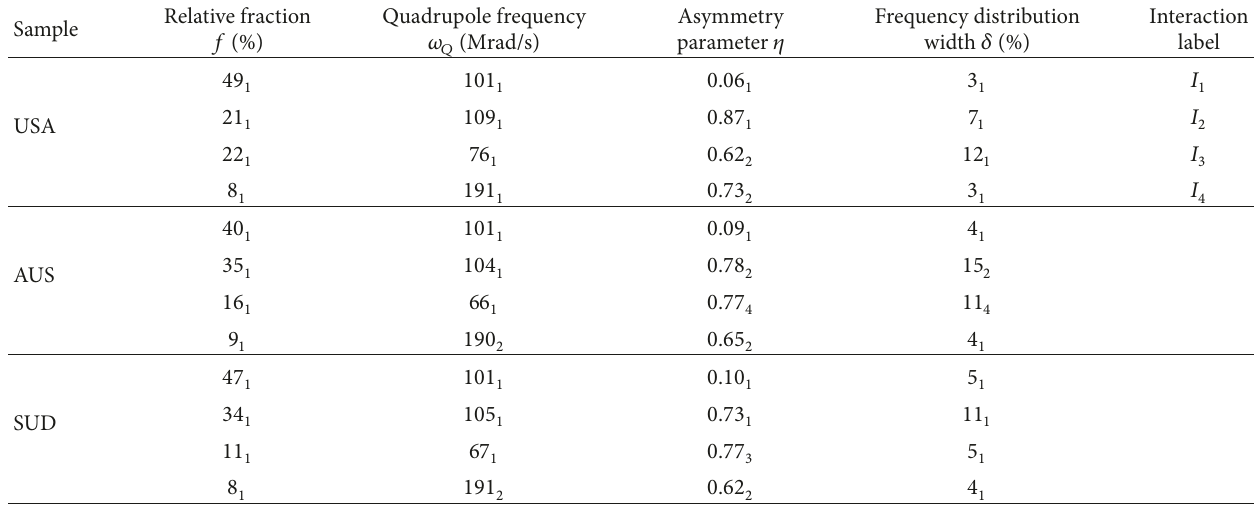
Table 3: Hyperfine quadrupole parameters fitted to the experimental PAC results. Errors are indicated as subindexes.